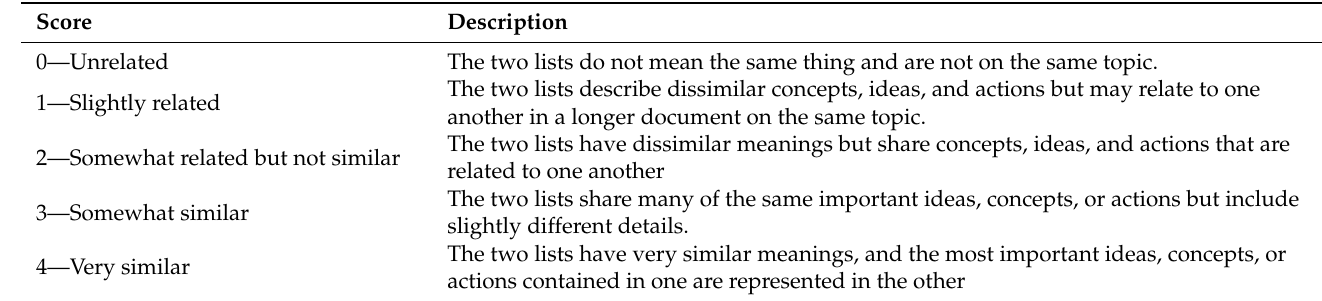
Table 3. The Likert scale that human annotators used to score the pair-wise relatedness and similarity between the topics.